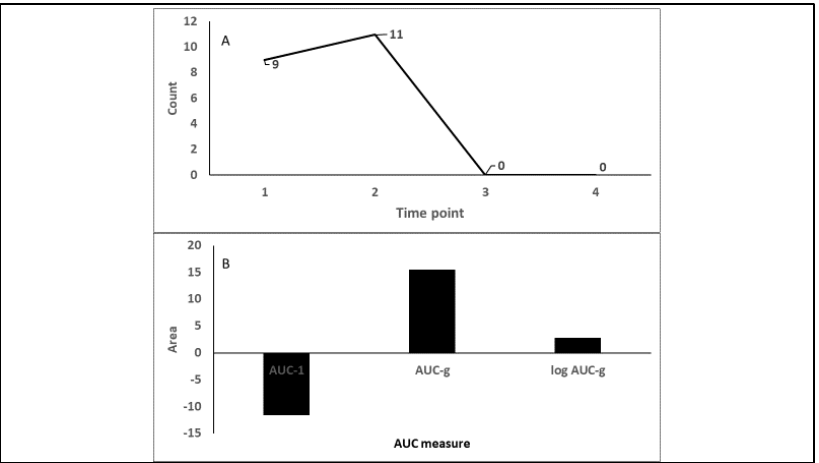
Figure 2. Histograms for the three area under the curve (AUC) measures for the N = 50 simulation. (Panel A ): AUC—i; (Panel B ): AUC—g; (Panel C ): LN AUC—g.